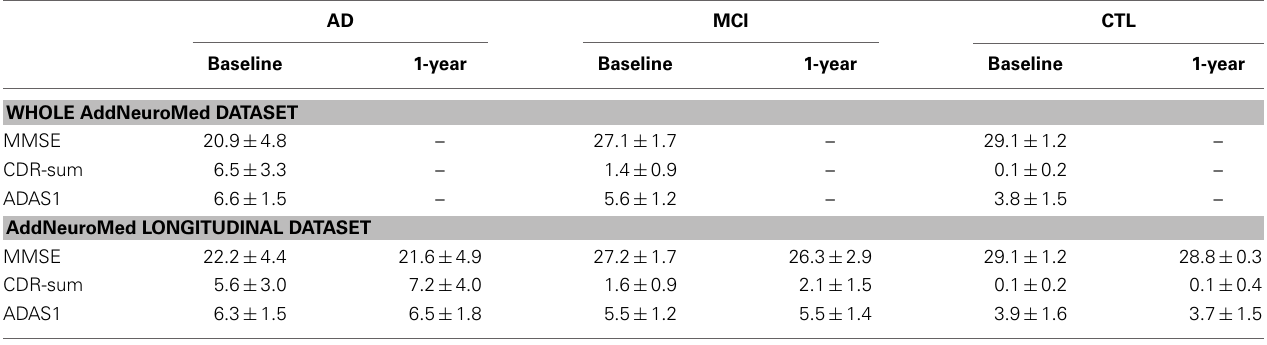
Table 2 | Cognitive scores at baseline and 1-year follow-up.